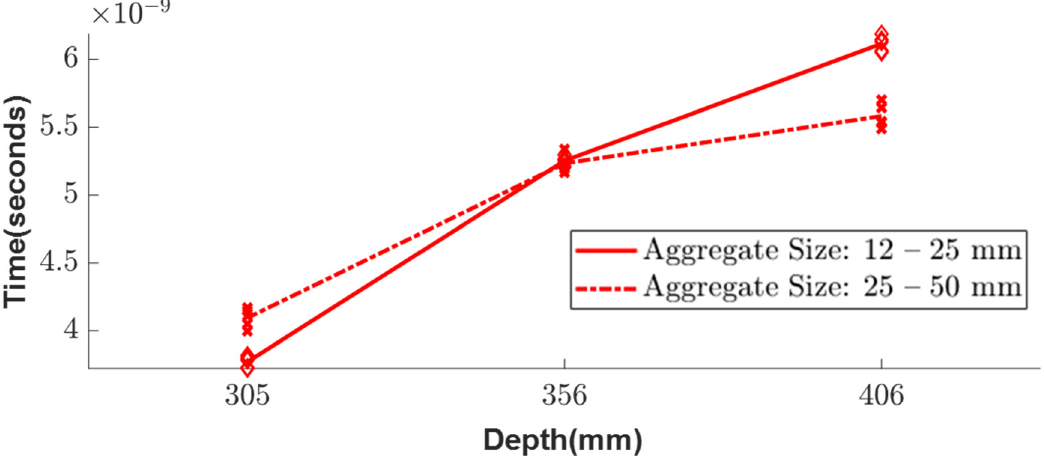
Figure 14. Sca tt er plot of the arrival time in simulation results for two di ff erent sizes of aggregates . Figure 14. Scatter plot of the arrival time in simulation results for two different sizes of aggregates.